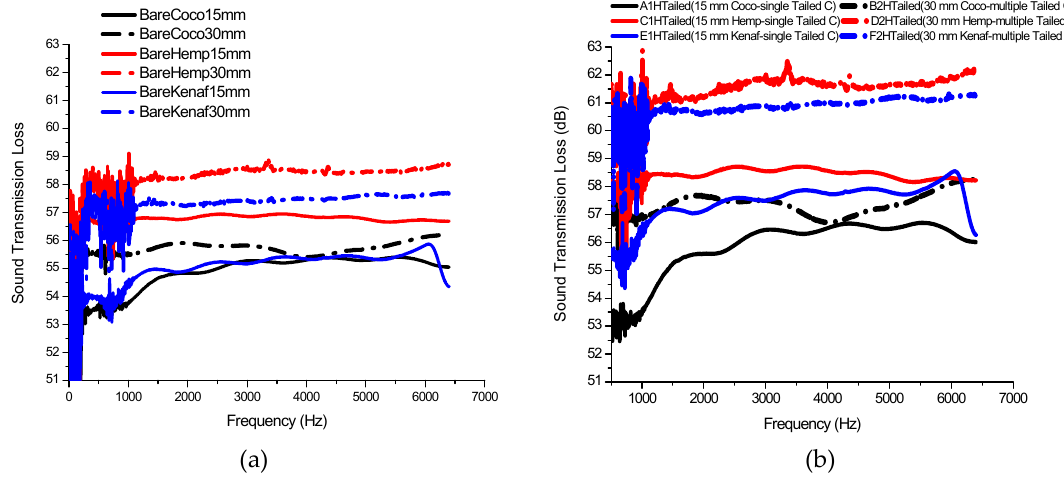
Figure 5. ( a ) STL of untreated Biomass Fiber specimens; ( b ) Comparison of STL of Biomass fiber reinforced polyester with single and multiple tailed cavity inclusion.